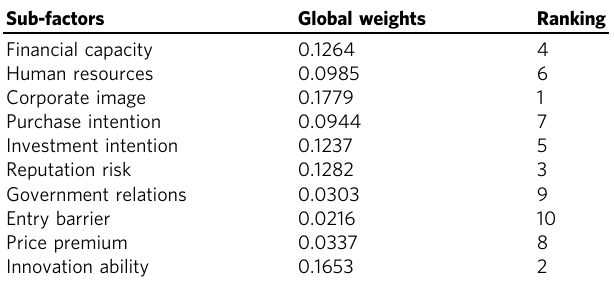
Table 11 The global weight of each sub-factor.